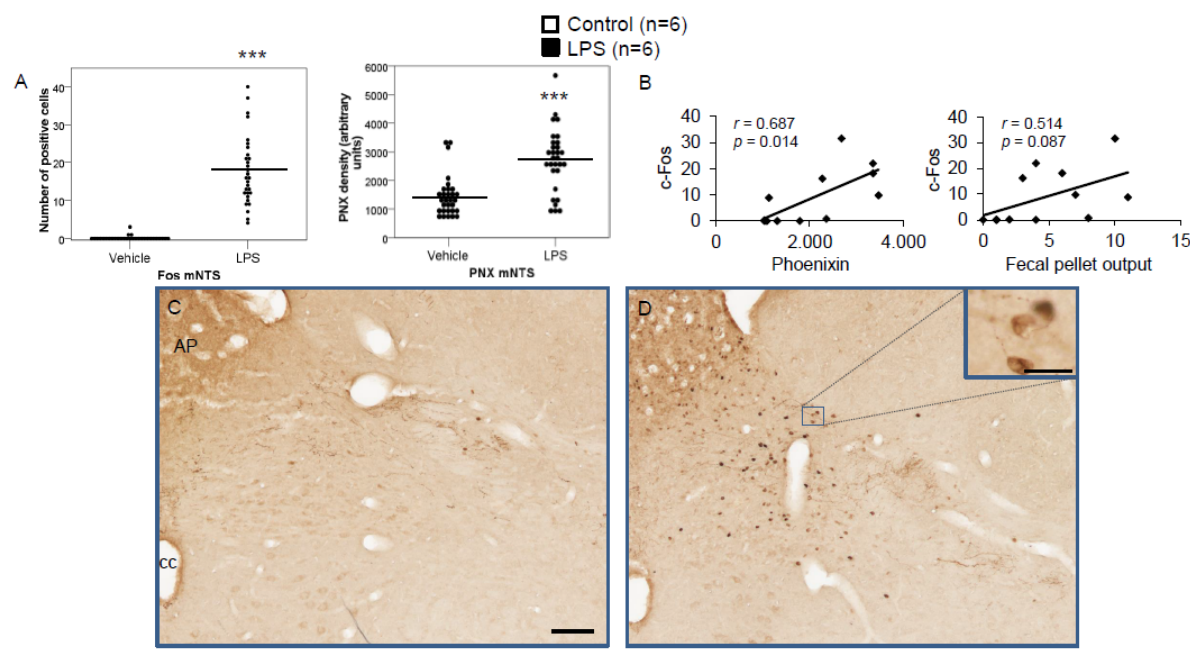
Figure 8. LPS stimulates c-Fos and phoenixin expression in the nucleus of the solitary tract. Ad libitum-fed rats were subjected to IP injection of LPS or control, and 180 min after the injection, brains were processed for c-Fos and phoenixin double-immunohistochemistry. LPS stress significantly increased the number of c-Fos-positive cells and increased phoenixin expression in the NTS ( A ). A significant correlation was observed between c-Fos and phoenixin immunoreactivity in the NTS ( A ), while the correlation between the number of c-Fos-positive neurons and fecal pellet output was non-significant. Representative pictures of the evaluated slides are shown in ( C ) (control) and ( D ) (LPS). The scale bar represents 100 µ m in the overview and 20 µ m in the insert. Data are expressed as individual data points (5/animal) and mean in ( A ). Mean values per animal are plotted in ( B ). *** p < 0.001. Abbreviations: AP, area postrema; cc, central